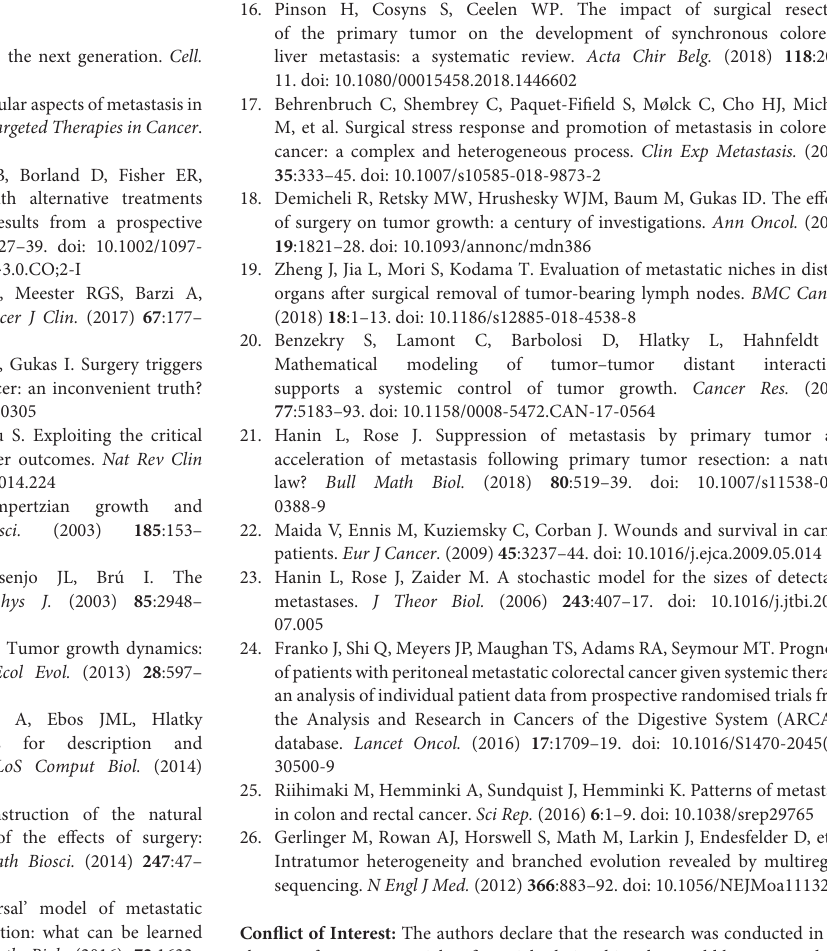
Figure S1 | CT images from dates W2–5. The metastases are marked by arrows. Figure S2 | A scheme based on the CT scans, showing locations of all 10 diagnosed metastases in the